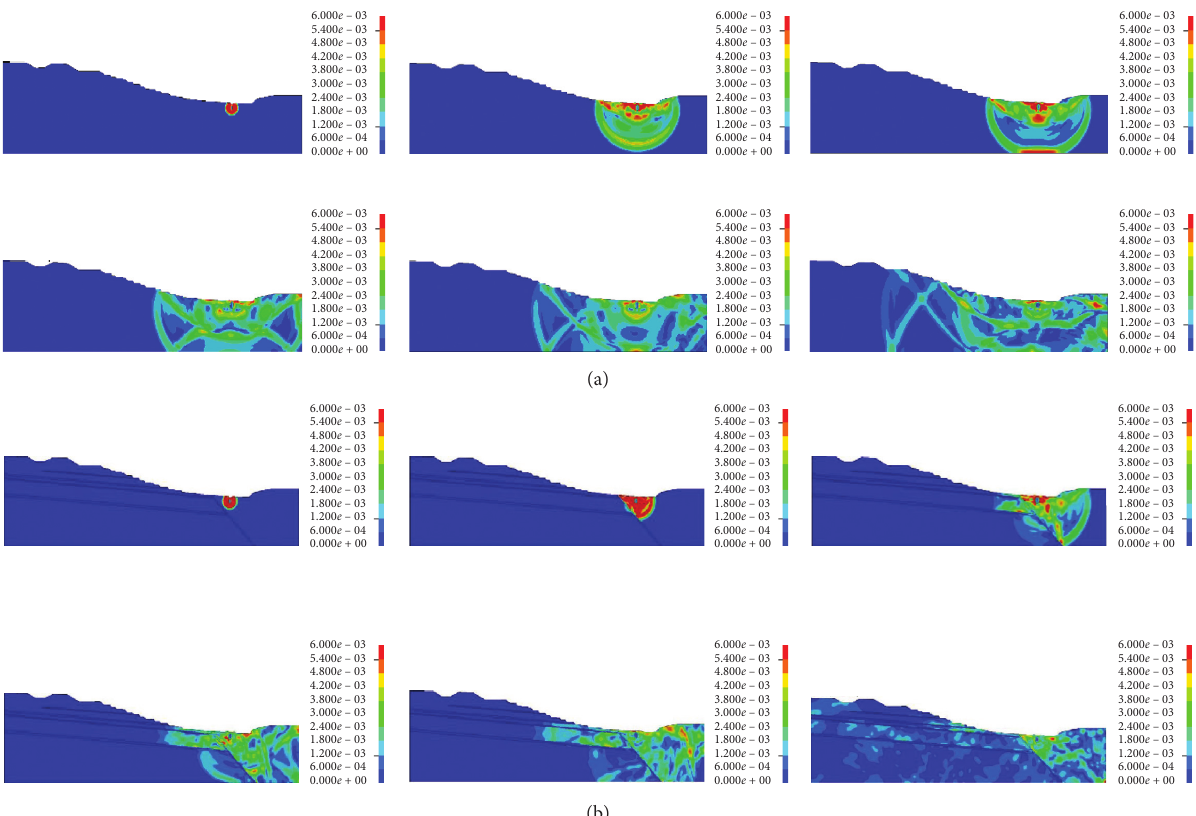
Figure 9: Equivalent stress nephograms of two slopes under blasting loads. (a) The homogeneous slope. (b) The slope with weak intercalated